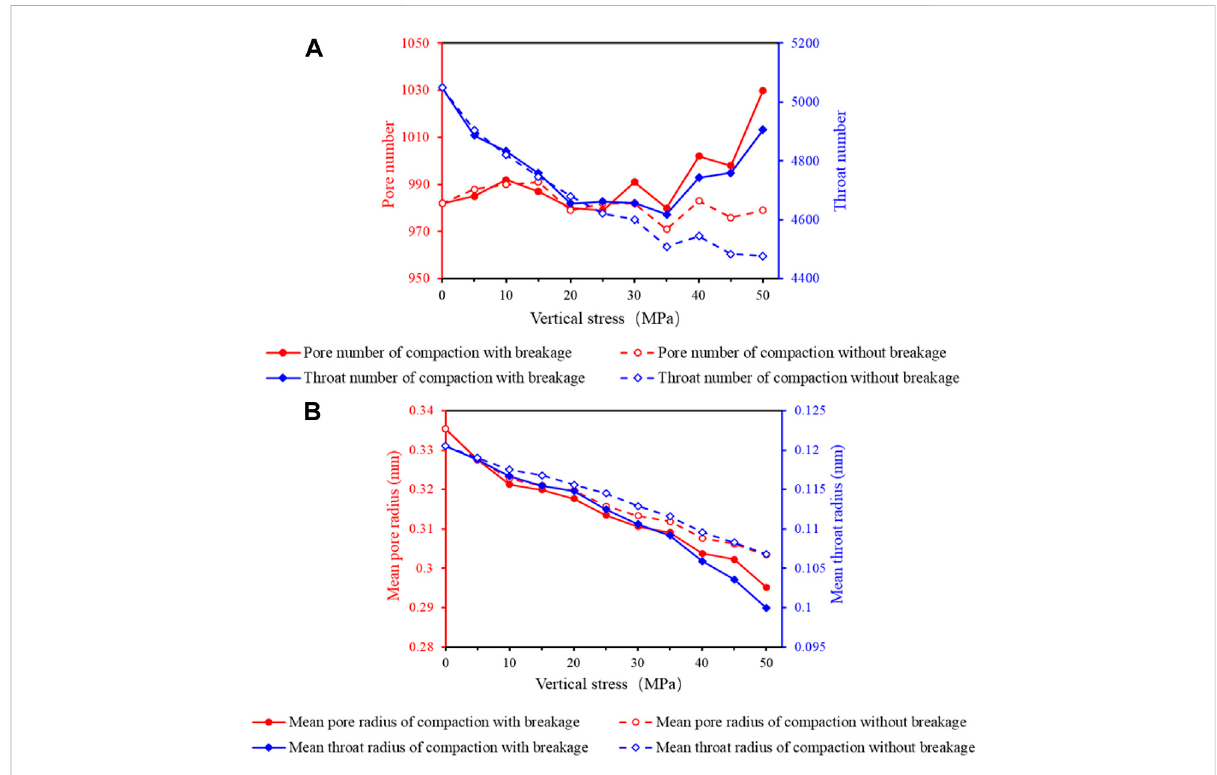
FIGURE 20 Evolution of the pore structure characteristics of the simulation with and without breakage: (A) number of pores and throats and (B) the mean radii of pores and throats.